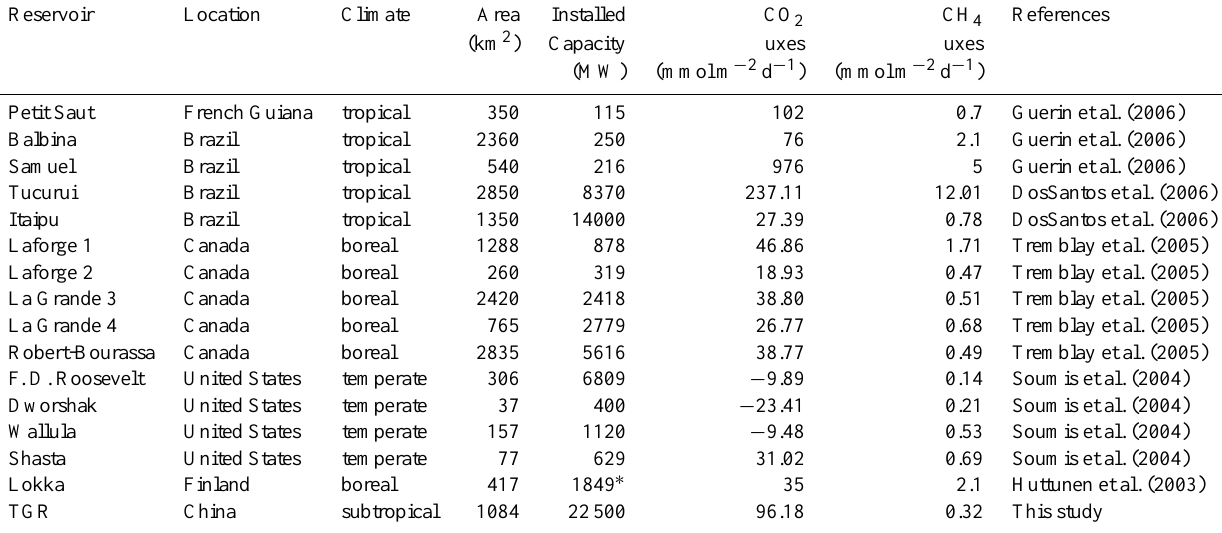
Table 3. CO 2 and CH 4 emissions of per unit installed power generation